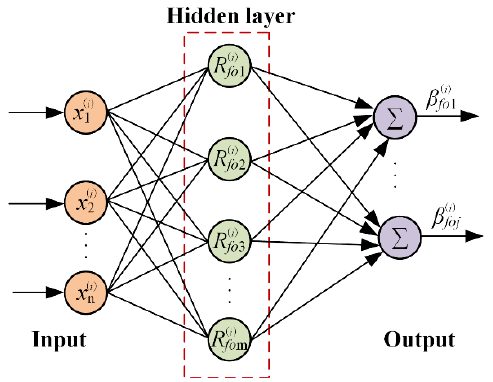
Figure 5. Radial Basis Neural Network Structure.